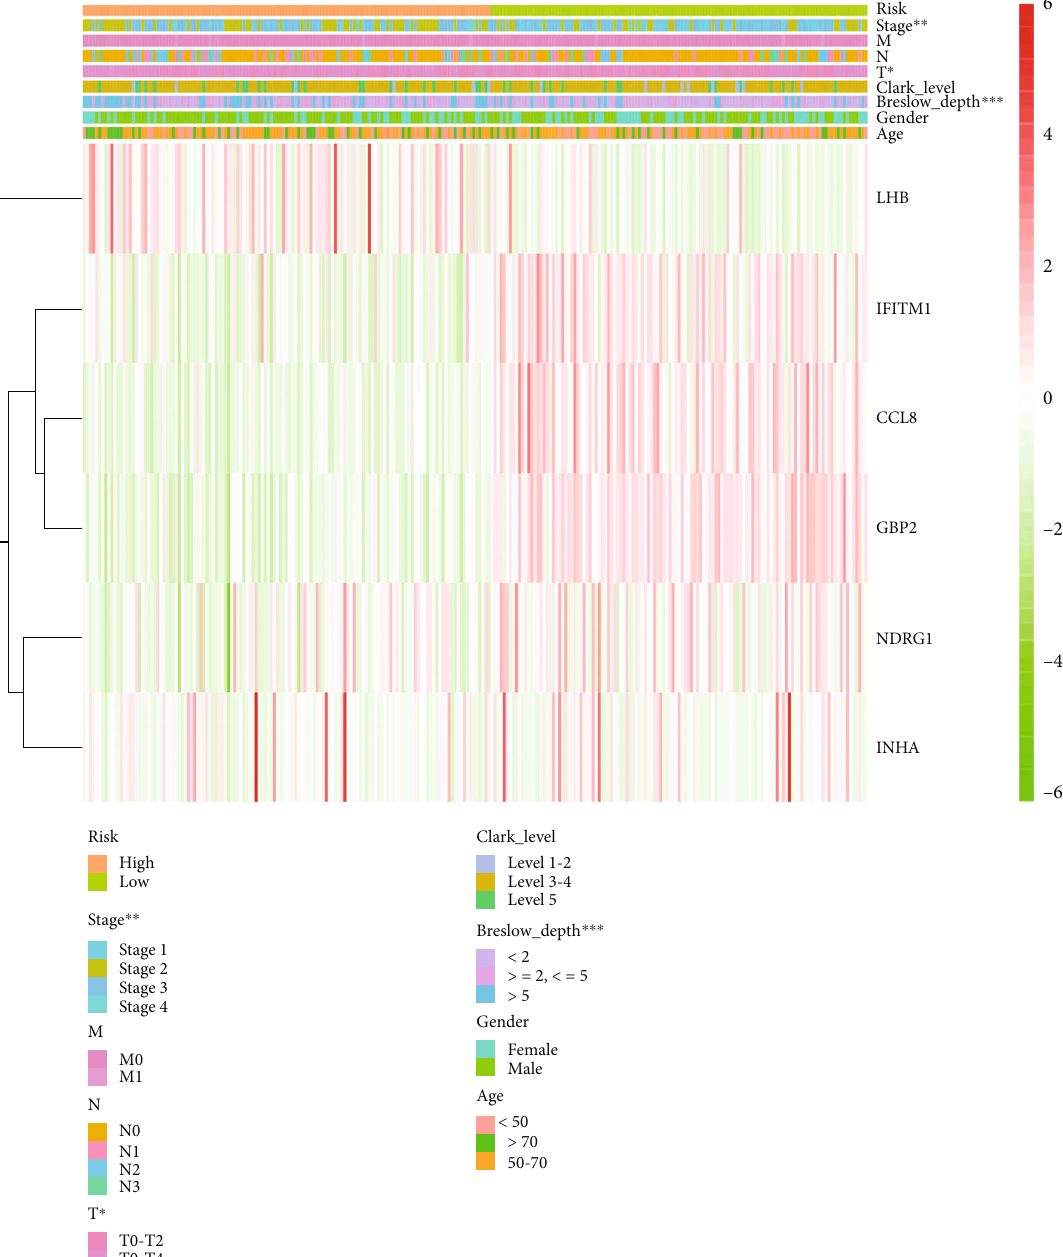
Figure 2: The heat map that showed the expression of six IAGs and the distribution of clinicopathological variables. IAGs: immune- associated